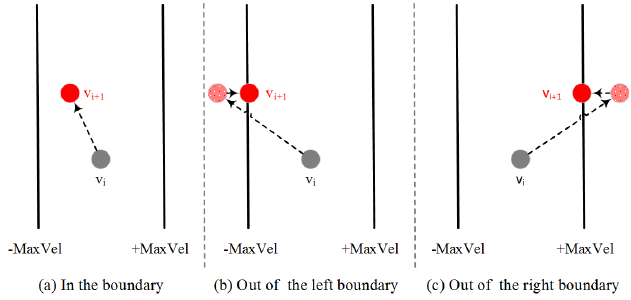
Figure 3. Velocity updating